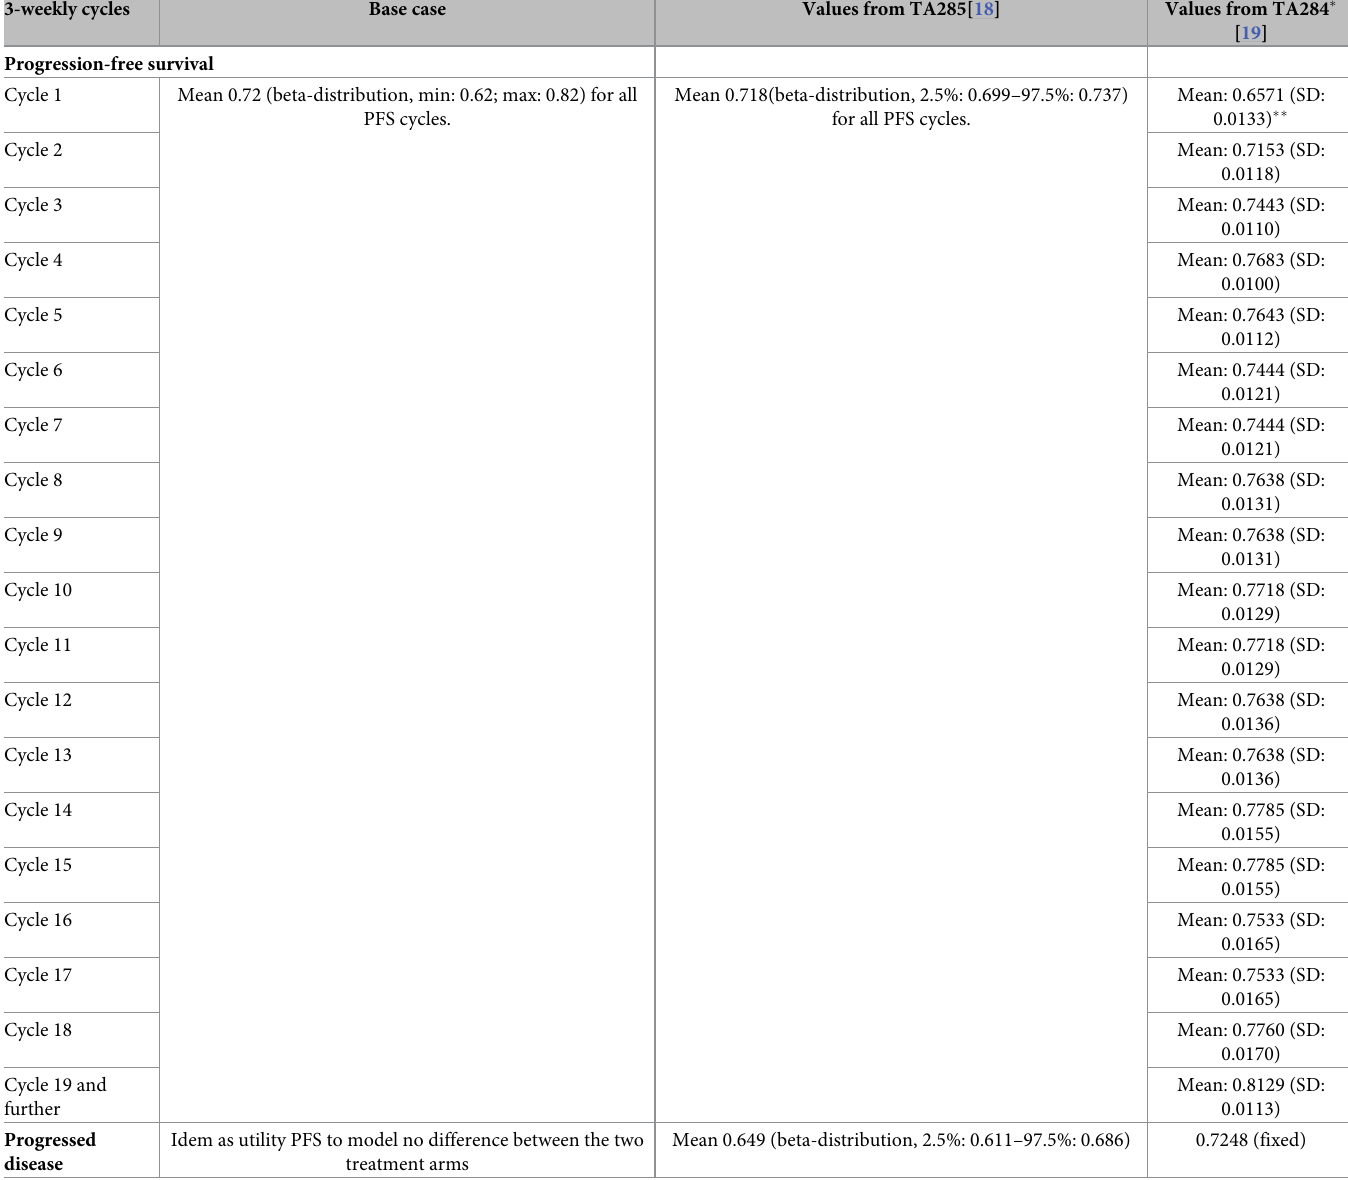
Table 3. QoL values. 3-weekly cycles Base case Values from TA285[18] Values from TA284 (cid:3) Progression-free